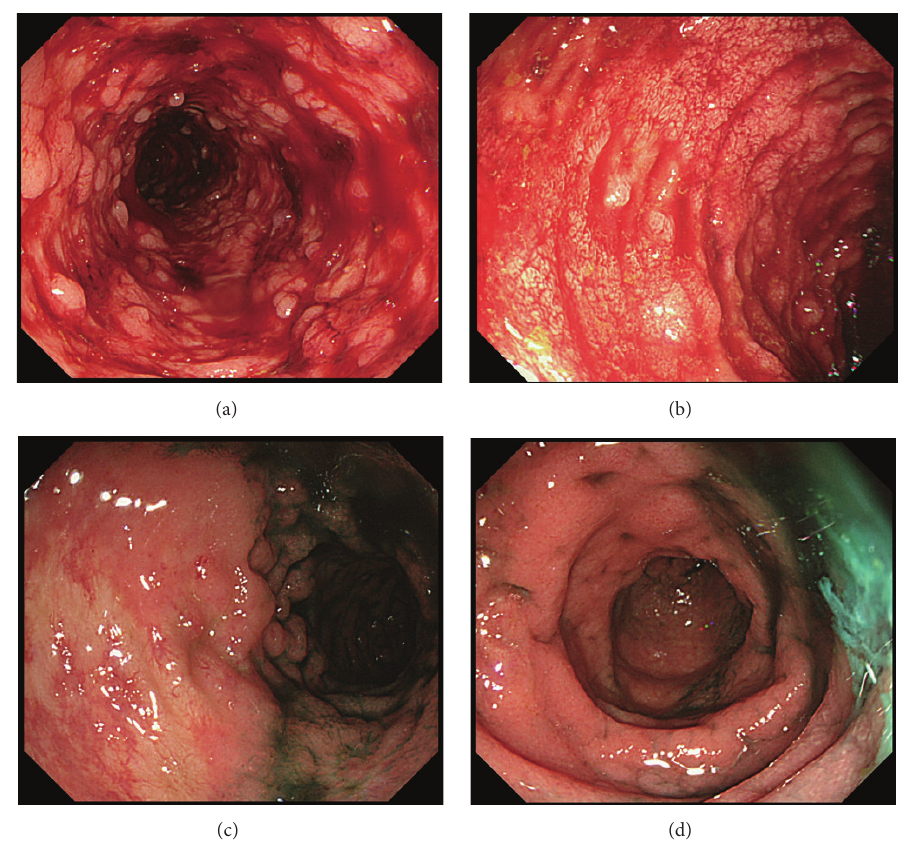
Figure 2: Total colonoscopy results before and after treatment. (a) Descending colon and (b) sigmoid colon before treatment, showing diffuse mucous erythema, spontaneous bleeding, and ulcerations. Disappearance of a vascular pattern was also observed. (c) Descending colon and (d) sigmoid colon after treatment, showing improvement of mucous